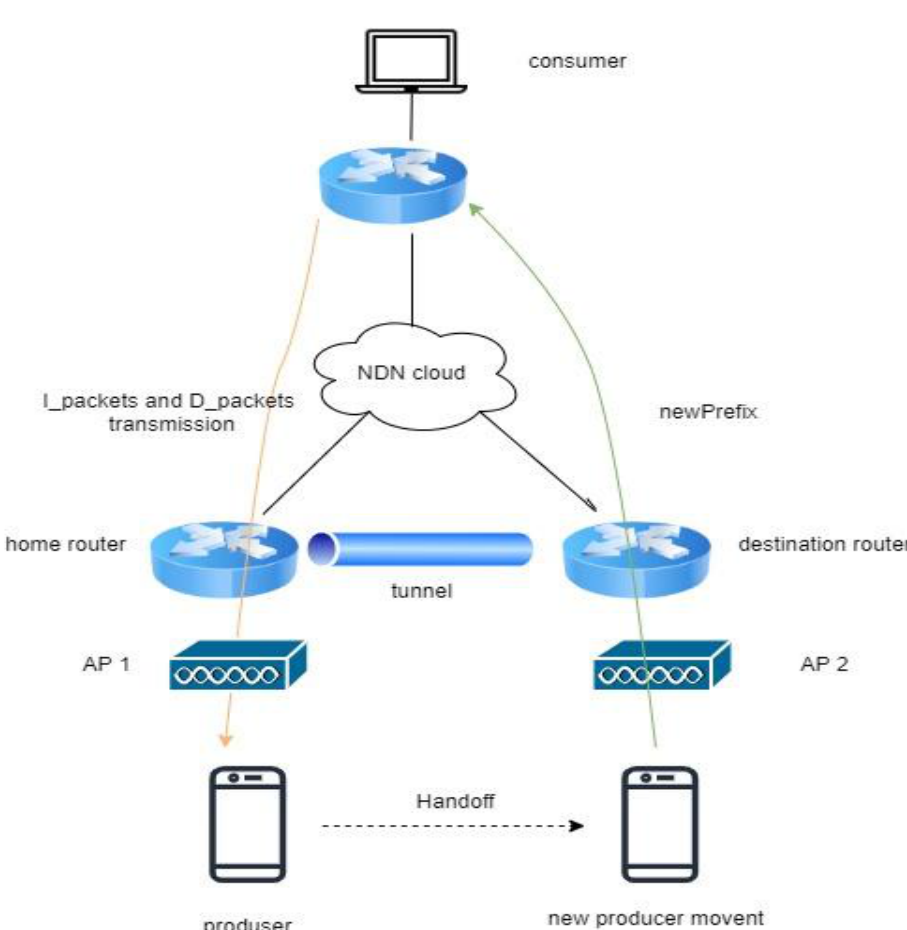
Figure 4. General NDN simulation scenario.